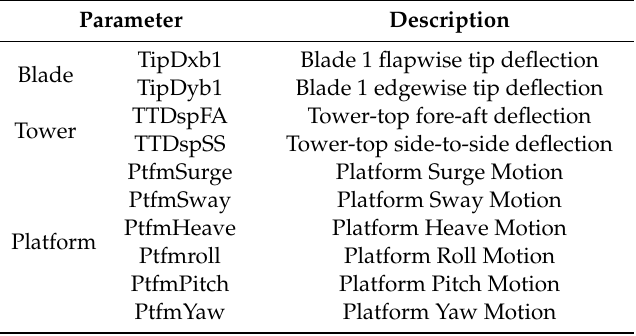
Table 3. Input features of deep learning neural